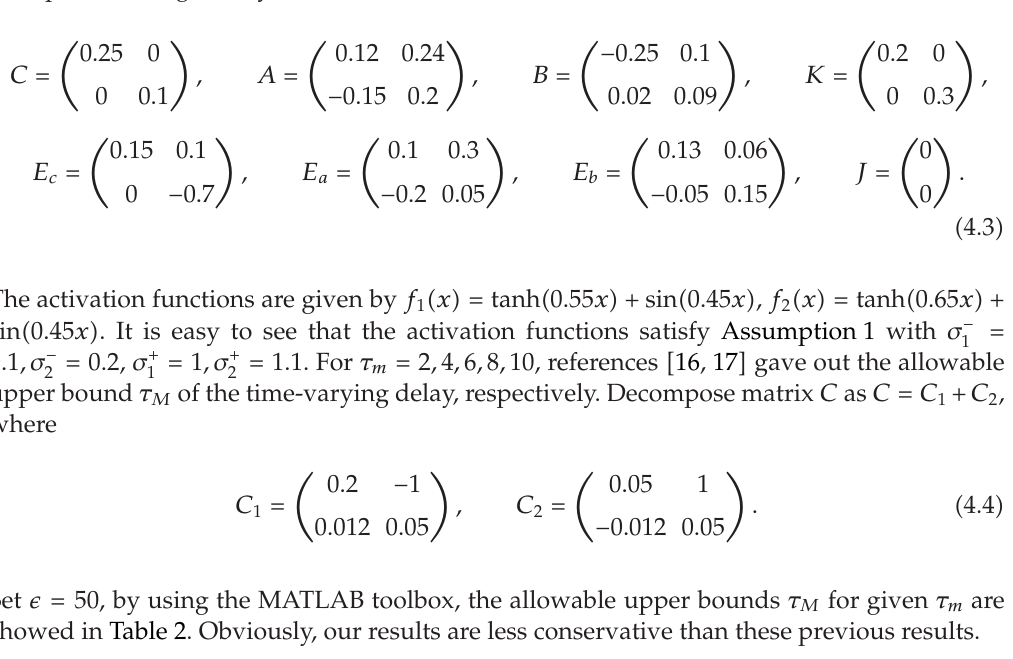
Table 2: Allowable upper bounds τ